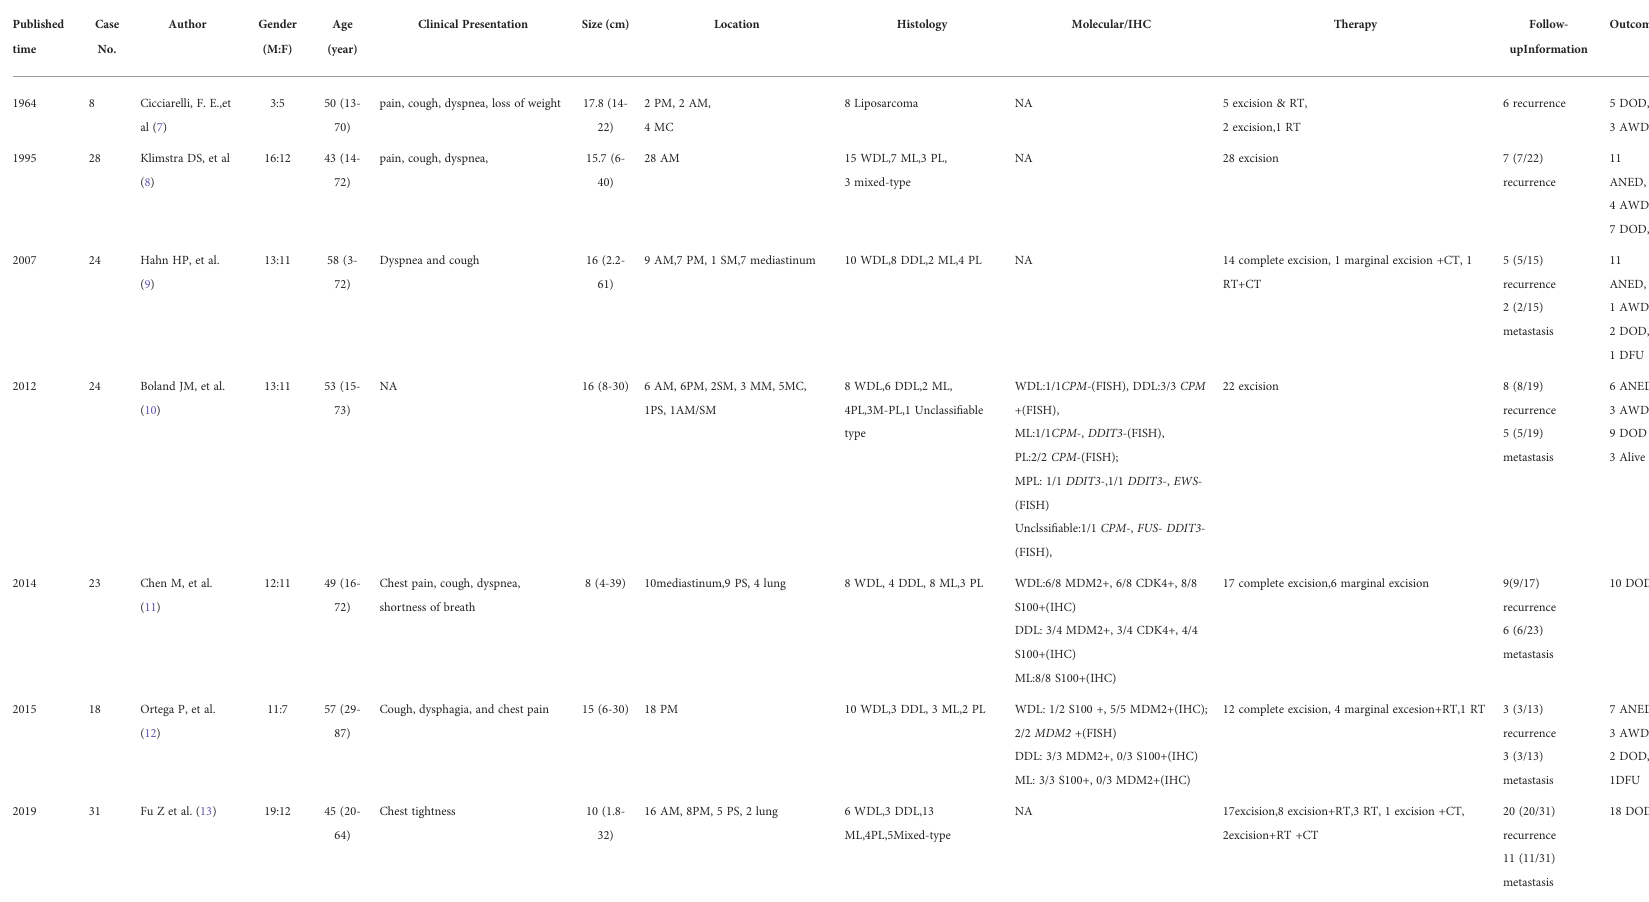
TABLE 3 Clinicopathologic features of previously reported primary mediastinal and intrathoracic liposarcomas of large series studies. Published Case time